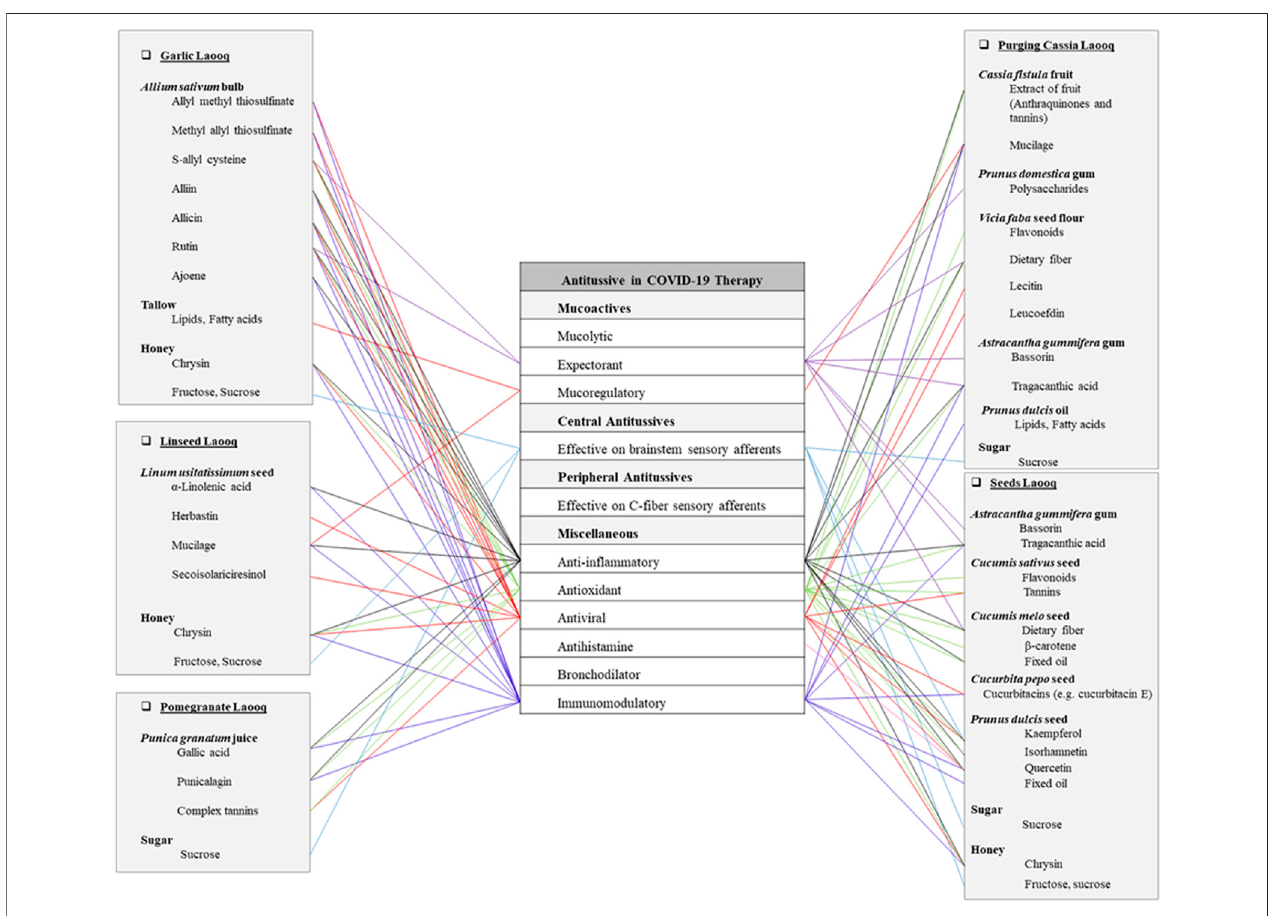
FIGURE 1 | Potentials of antitussive Persian Laooqs in COVID-19